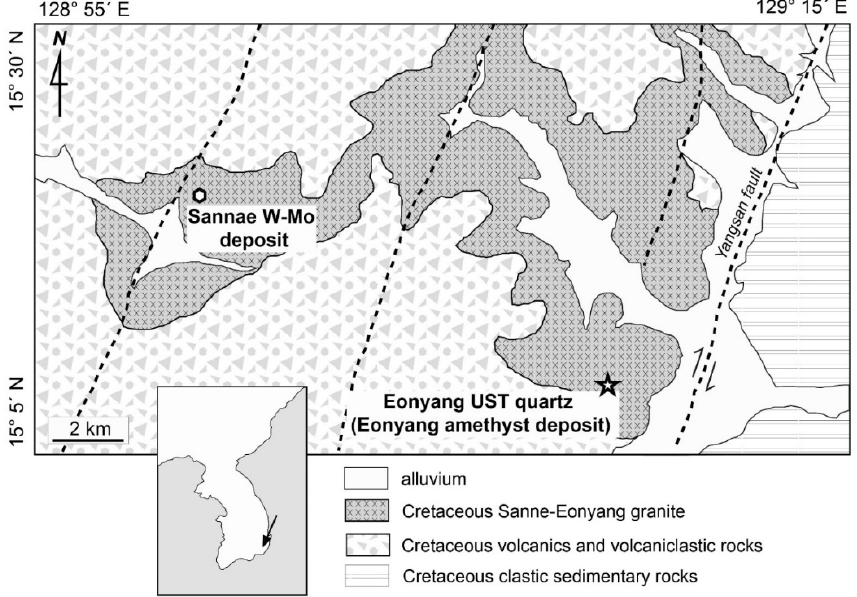
Figure 1. Geological map of Sannae-Eonyang granite and locations of the Eonyang amethyst and Sannae W-Mo deposit. Dashed lines represent clockwise strike-slip faults, including the Yangsan transform fault. Eonyang UST quartz is sampled from the Eonyang amethyst deposit.